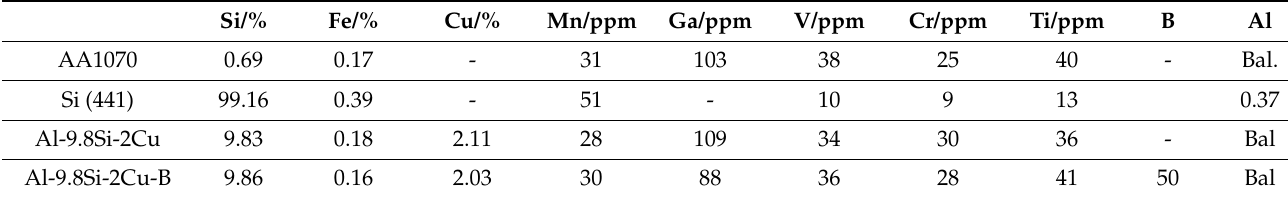
Table 2. Compositions of pure Al ingot and Al-9.8Si-2Cu with/without Al-B master